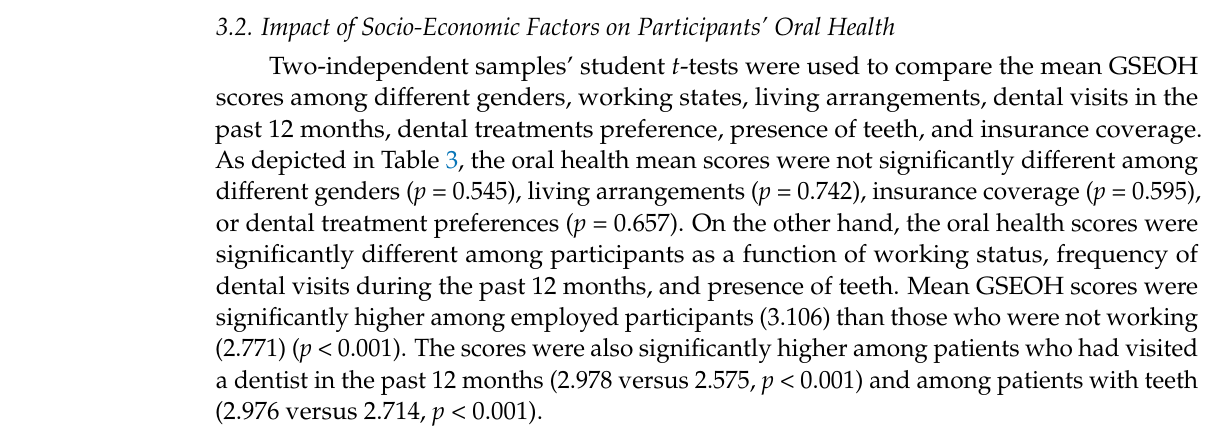
Table 3. Comparison of the mean GSEOH scores among different genders, working states, living arrangements, dental visits in the past 12 months, dental treatments preference, presence of teeth, and insurance